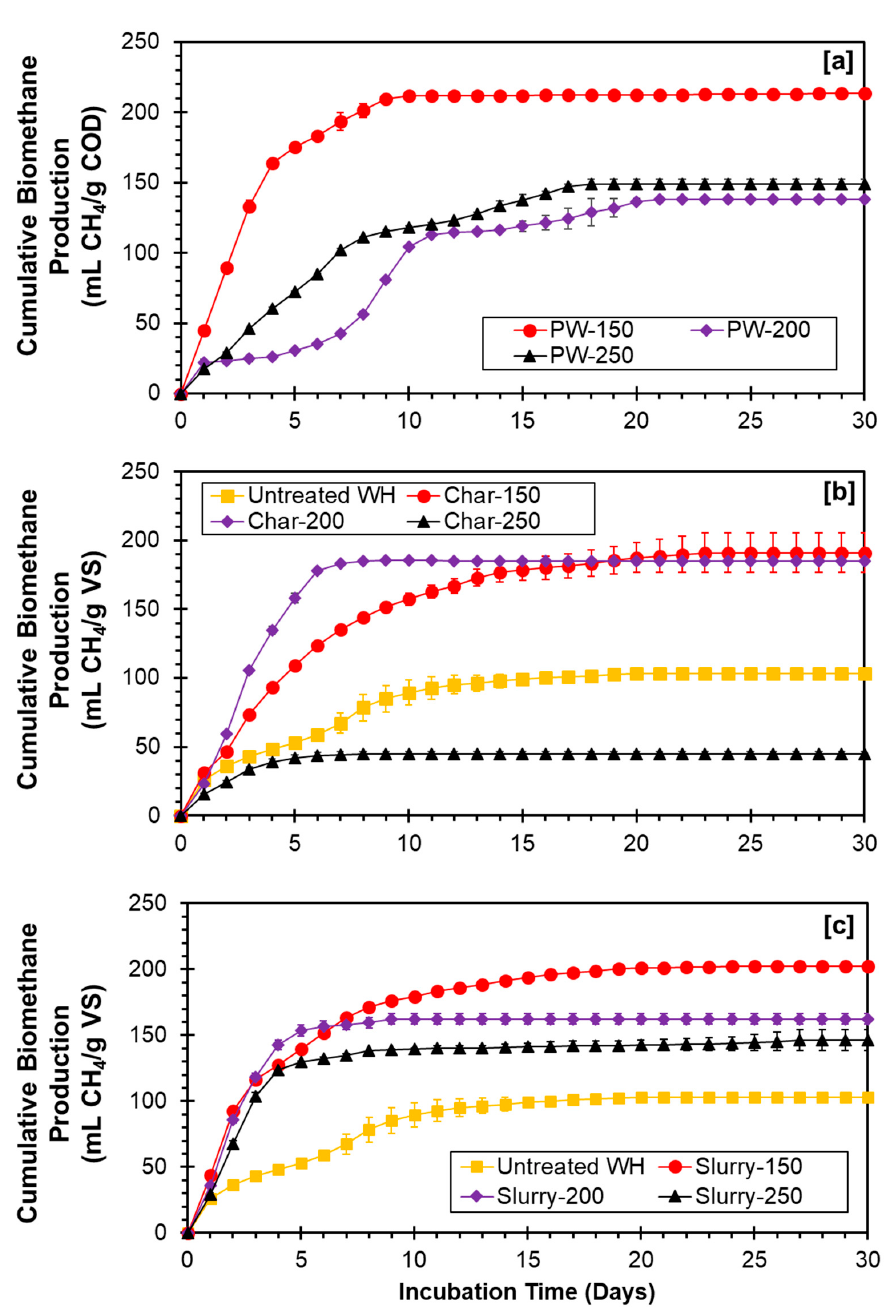
Figure 4. Experimental biochemical methane potential (BMP ex ) of untreated water hyacinth (WH) and WH hydrothermal carbonisation (HTC) products. The BMP ex is shown for ( a ) process waters, ( b ) hydrochars, and ( c ) HTC slurries. Data is presented as average values. Error bars represent the minimum and maximum values ( n = 2). PW-150 = HTC process water produced from WH at 150 °C. PW-200 = HTC process water produced from WH at 200 °C. PW-250 = HTC process water produced from WH at 250 °C. Slurry-150 = HTC slurry produced from WH at 150 °C. Slurry-200 = HTC slurry produced from WH at 200 °C. Slurry-250 = HTC slurry produced from WH at 250 °C.